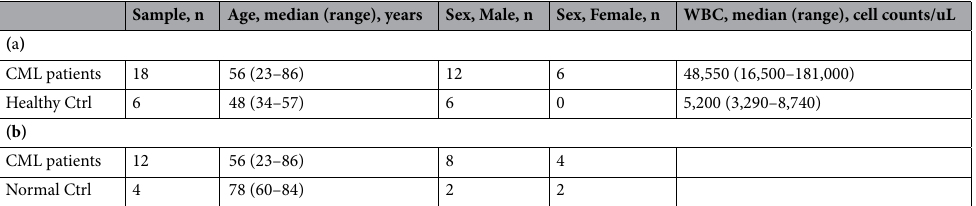
Table 1. Patient characteristics: (a) Patients and control individuals for peripheral white blood cell (WBC) analysis, (b) Patients and control individuals for bone marrow cells analysis. n numbers, y